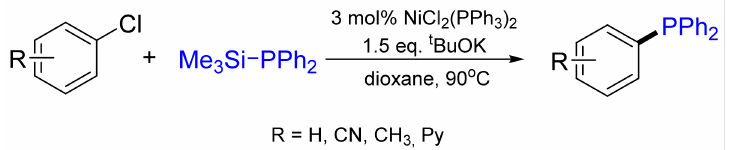
Figure 2. Nickel-catalyzed cross-coupling with